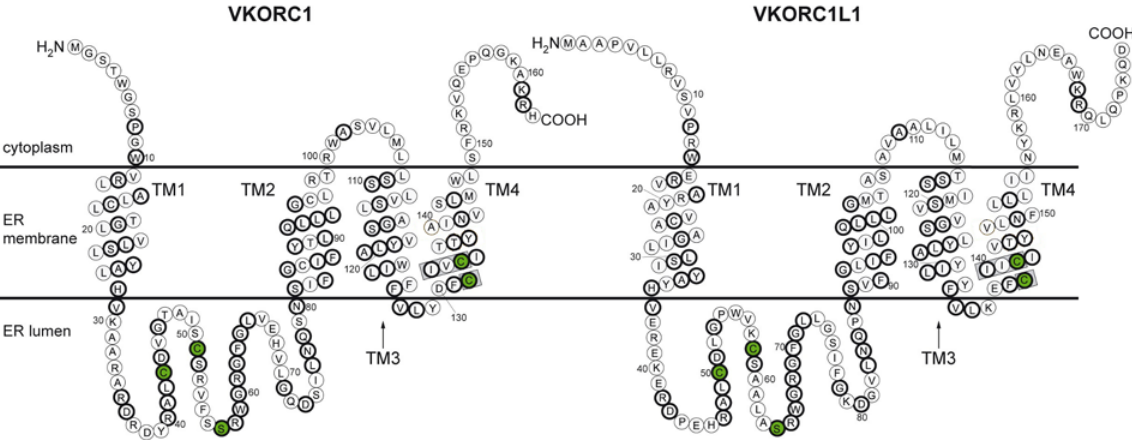
Figure 1. Primary protein sequence and predicted topology of human VKORC1 (left) and VKORC1L1 (right). Circles represent amino acid residues; bold circles indicate positions of sequence identity shared by both paralogs; green-filled circles, residues conserved among all VKOR family proteins; TM1–TM4, first through fourth transmembrane α-helices; gray-boxed regions, the catalytic CXXC active site motif.